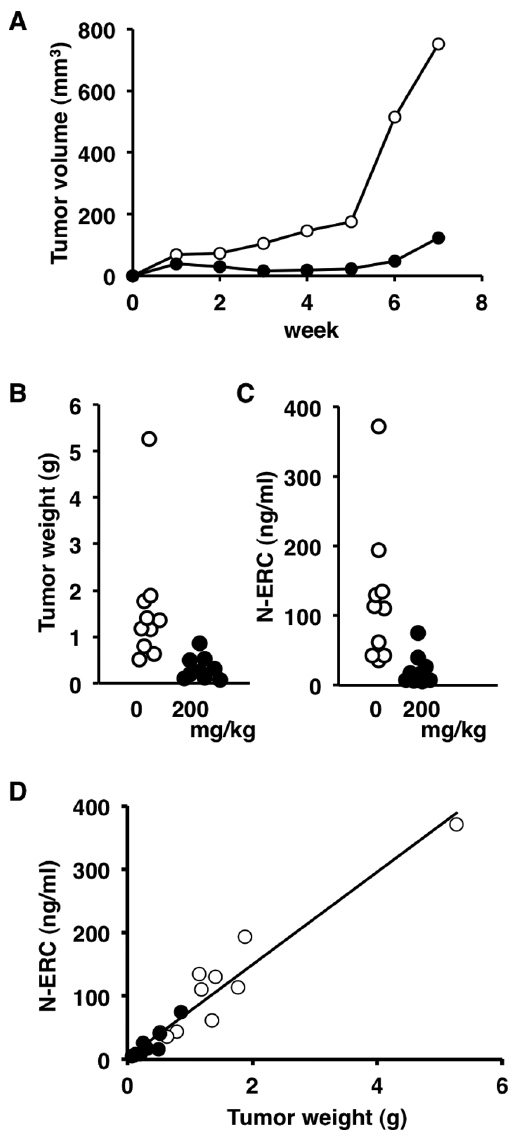
Figure 5. Effect of gemcitabine in NOD-SCID mice with transplanted 634NOD cells. Rat pancreas cancer cells (634NOD cells) were implanted subcutaneously into the flank of NOD-SCID mice. After 1 week the mice were administered gemcitabine (0 or 200 mg/kg, i.p.) four times within nine days by intraperitoneal injection. (A) Periodic observation of tumors in NOD-SCID mice treated with gemcitabine (0 mg/kg, open circles; 200 mg/kg, closed circles). (B) The tumor weight and (C) serum level of N-ERC/mesothelin was significantly decreased by treatment with gemcitabine (200 mg/kg, closed circles) compared to control (open circles) (P , 0.05, P , 0.01 respectively). (D) Correlation of tumor weight and serum levels of N-ERC/mesothelin. The serum level of N-ERC/mesothelin correlated with tumor weight and gemcitabine treatment (R=0.966). Open circles, 0 mg/kg; closed circles, 200 mg/kg.